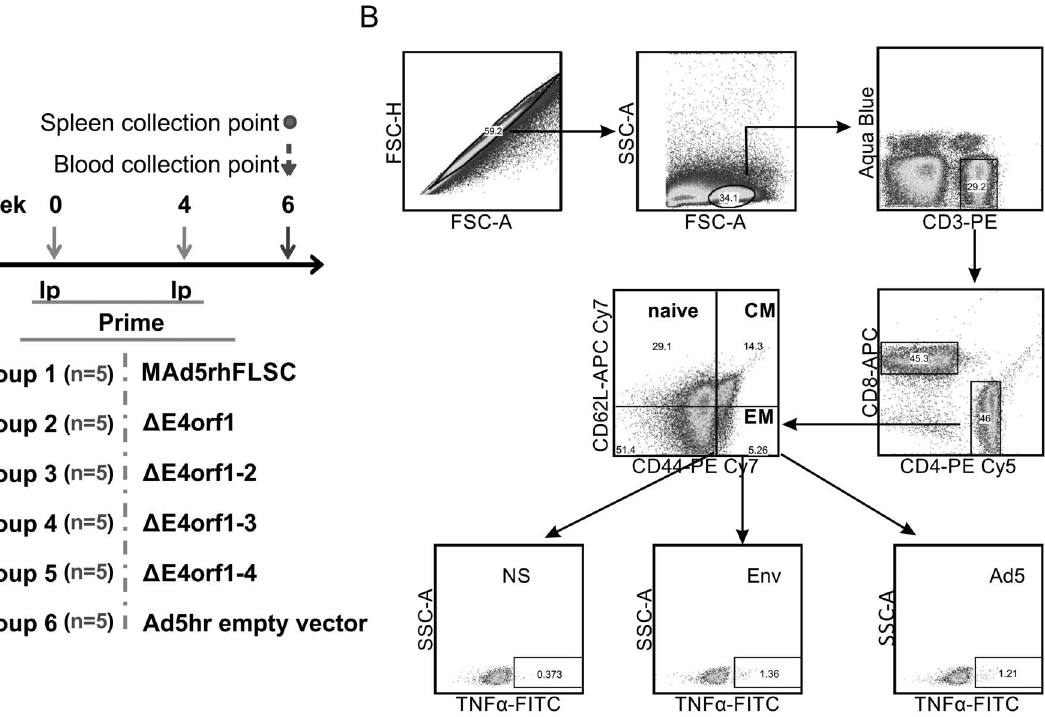
Figure 7. Vaccination Scheme and gating strategy. ( A ) Five 6–8 weeks of age female Balb/c mice per group were vaccinated at the indicated times with 5.0 6 10 8 PFU of the listed viruses. On week six spleen and blood were collected from each animal. ( B ) Cells were first gated for singlets (Forward Scatter-High (FSC-H)/Forward Scatter-Area (FSC-A), lymphocytes (Side Scatter-Area (SSC-A)/FSC-A) and viable CD3 cells (aqua blue/CD3). CD8 and CD4 subpopulations were identified and further separated into either central or effector memory (CM and EM respectively) subpopulations based on CD62L and CD44 as indicated. Representative examples of non-stimulated (NS), gp120 envelope peptide stimulated (Env) and Ad5 fiber peptide (Ad5) stimulated EM cells producing TNF a are shown.